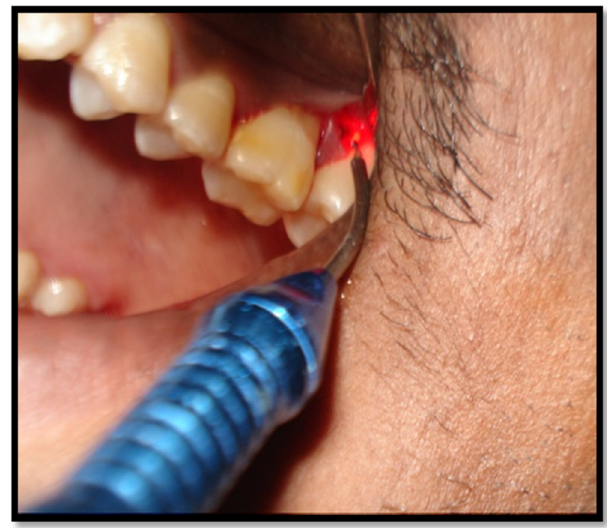
Figure 3. Application of low-level laser therapy on the debrided intrabony defect. To prevent any eye injury, both the patient and clinician wore safety goggles during laser irradiation. A vertical external mattress suture was placed at the surgical site similar to that in the control group in order to ensure repositioning. Primary flap closure was obtained by suturing (Figure 4). A coe-pack was placed at the sutured site. A single experienced operator performed all of the surgical procedures.